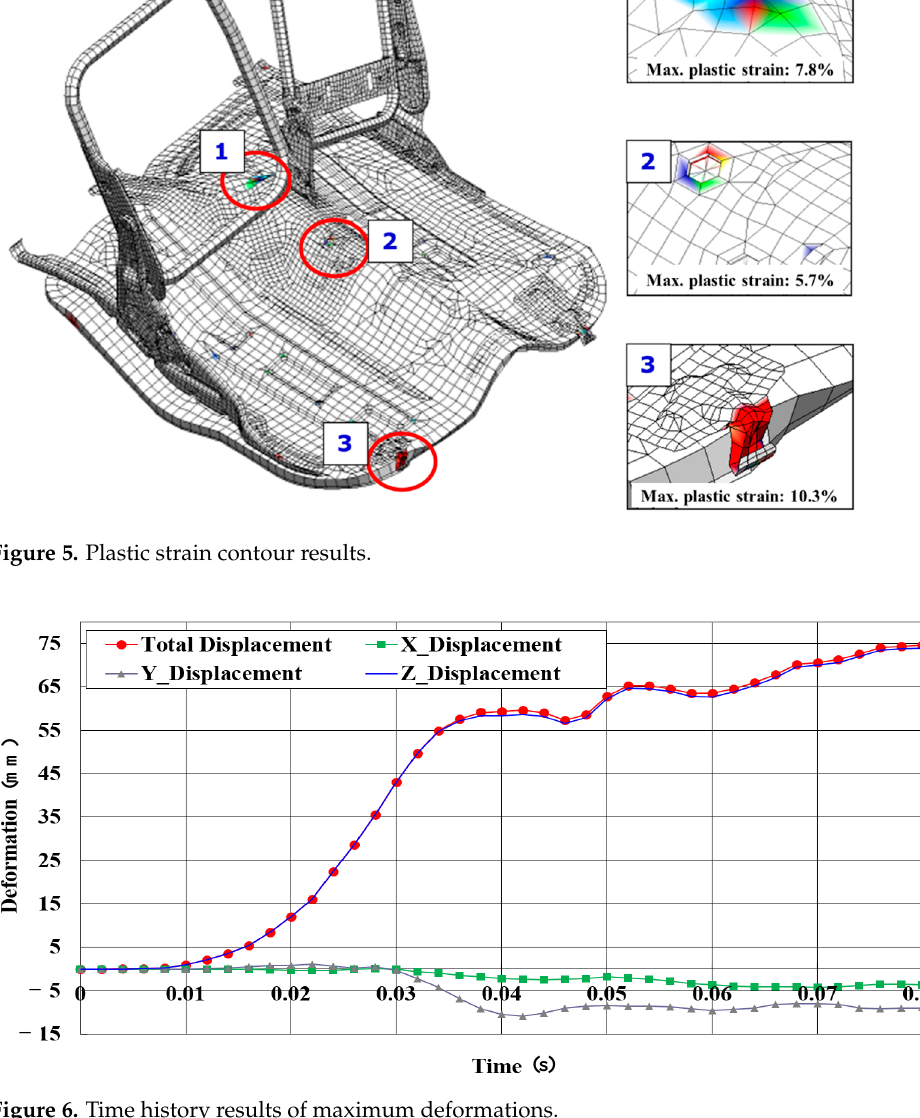
Figure 6. Time history results of maximum deformations.